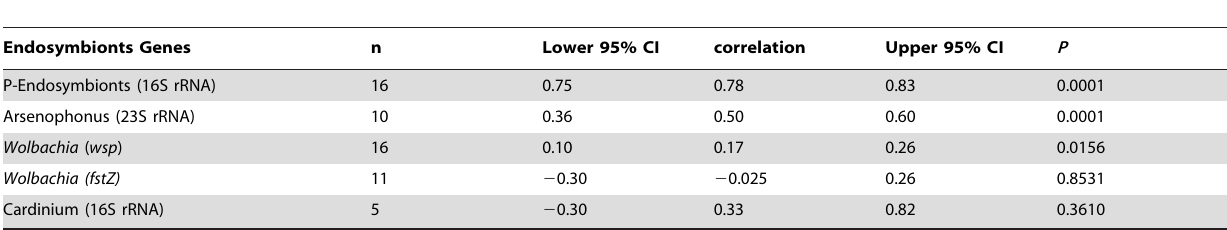
Table 1. The mantel correlations between the genetic differences between B. tabaci sequences and that of their endosymbionts.